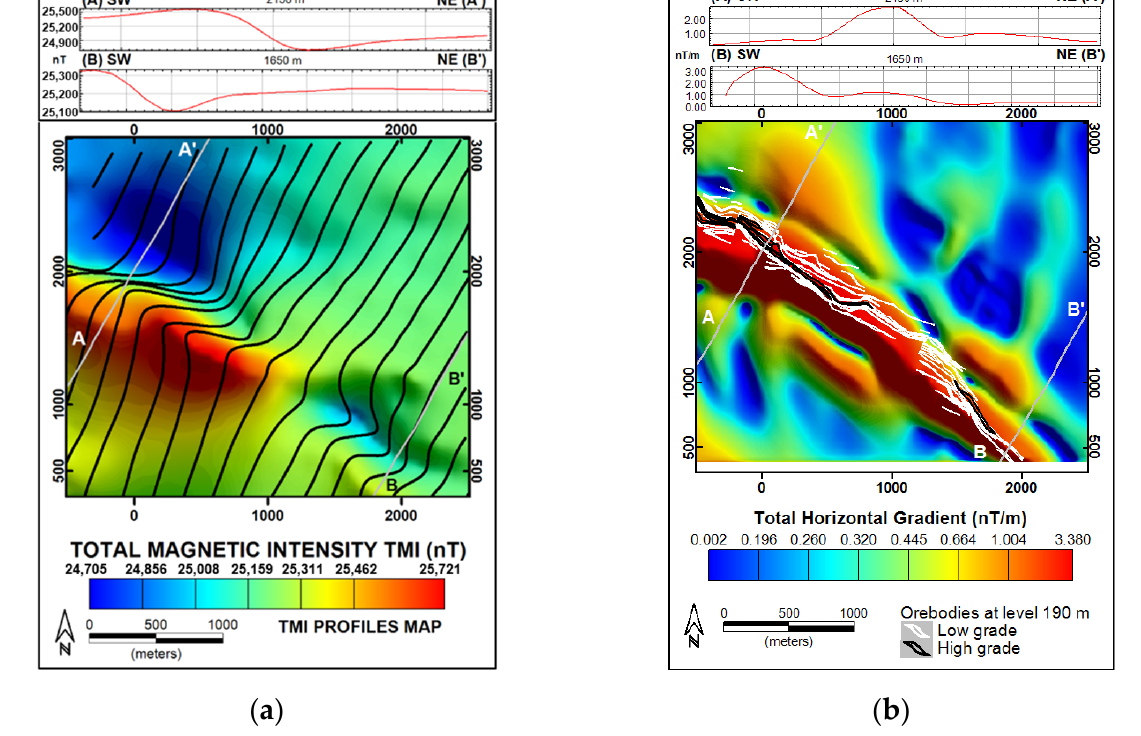
Figure 8. ( a ) The observed total-field magnetic data of the Furnas Southeast deposit. Total magnetic intensity profiles are shown over each flight line in black traces. Units in nT. ( b ) Correlation of high-grade >0.6% copper (black lines) and low-grade between 0.2% and 0.6% copper (white lines) orebodies with a total horizontal gradient of the anomalous magnetic field. Units in nT/m.